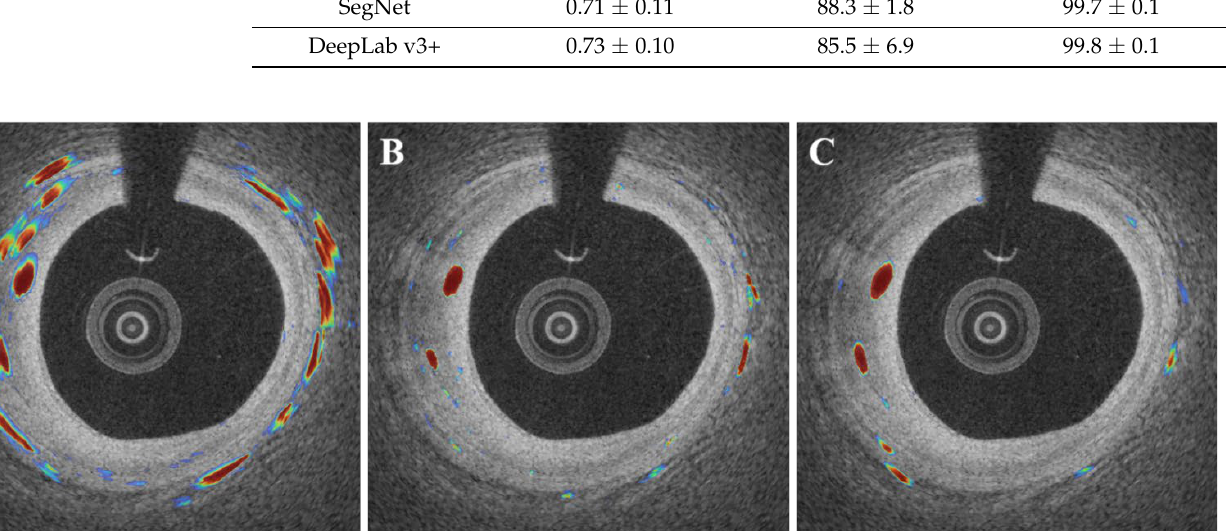
Figure 8. Examples of saliency maps obtained by different semantic segmentation networks (( A ): U-Net, ( B ): SegNet, and ( C ): DeepLab v3+). The U-Net ( A ) showed a number of false activations along the angular rotation ( r ), while SegNet and DeepLab v3 plus focused on the specific regions with microvessels.